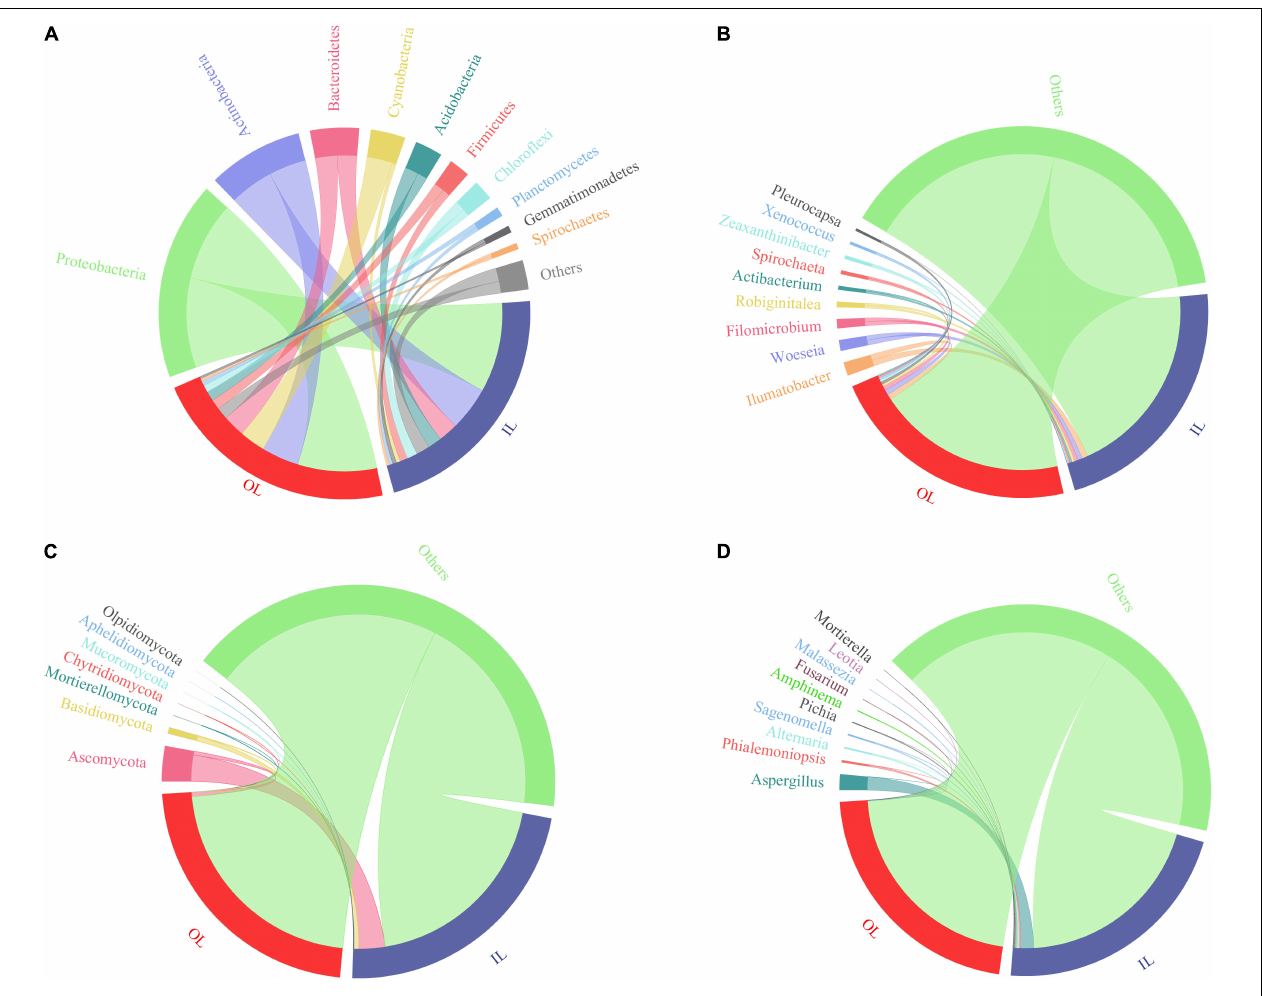
FIGURE 3 | Relative abundance of microbial taxa in the sediments from Qilianyu lagoon and surrounding area. Bacterial phyla (A) and genera (B) ; and fungal phyla (C) and genera (D) .